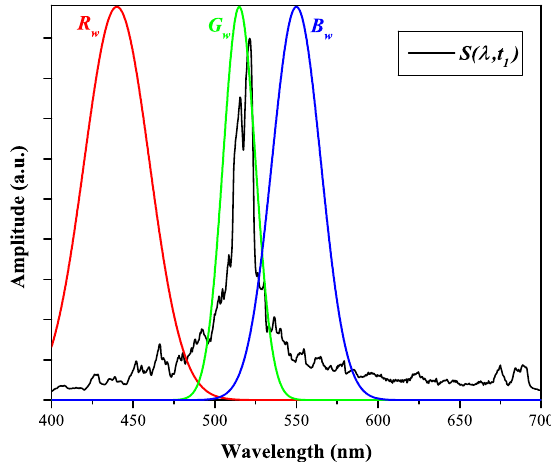
Figure 8. Wavelength domain processors R w , G w , B w superimposed upon a typical arc spectrum.